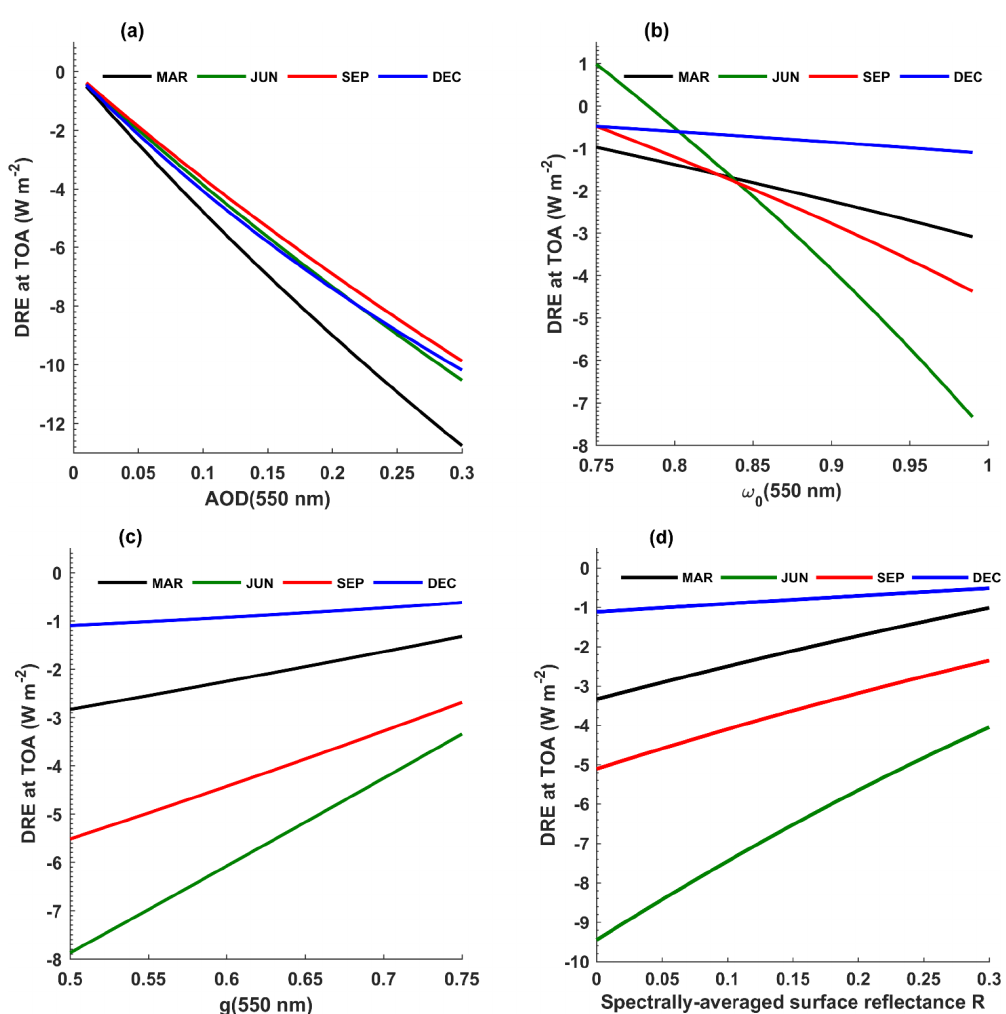
Figure 6. Seasonal dependence of the sensitivity of top-of-atmosphere (TOA) aerosol DRE to (a) AOD; (b) ω 0 ; (c) g ; and (d) spectrally- averaged surface reflectance R